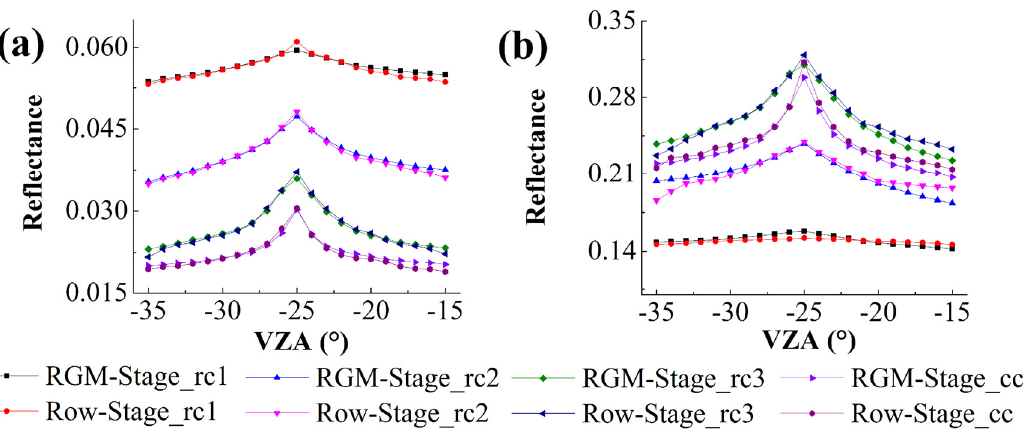
Figure 8. The distribution of reflectances for the single scattering near the hotspot (principal plane) model. ( a ) Single scattering near the hotspot in the red band, and ( b ) single scattering near the hotspot in the NIR band. Here, VZA is the viewing zenith angle.